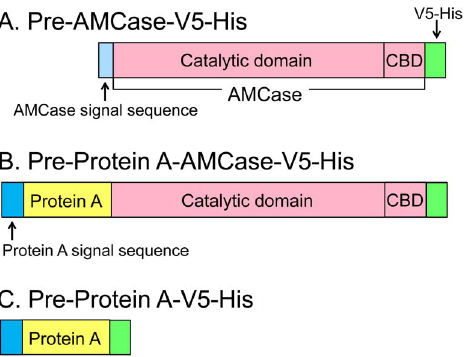
Figure 1. The schematic representations of the CHO- and E.coli - expressed mouse AMCase fusion proteins. Mouse AMCase is a secreted protein with a molecular mass of approximately 50 kDa, which contains an N-terminal catalytic domain and a C-terminal chitin-binding domain (CBD). (A) CHO-expressed pre-AMCase-V5-His. (B) E. coli - expressed pre-Protein A-AMCase-V5-His. (C) E. coli -expressed pre- Protein A-V5-His. The E. coli -produced proteins contain the affinity tail of Protein A at the N-terminus. CHO- and E. coli -recombinant proteins contain V5-His at the C-terminus. Newly synthesized recombinant proteins contain the AMCase signal sequence (A) or Protein A signal sequence (B and C).